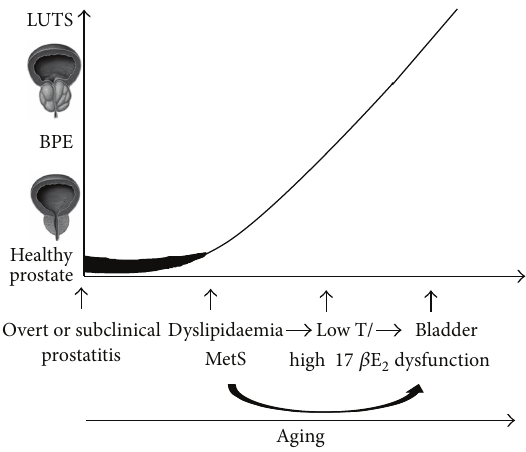
Figure 4: Graphical representation of a proposed multifactorial pathogenesis of benign prostatic hyperplasia/low urinary tract symptoms (BPH/LUTS). Symptomatic or asymptomatic prostate inflammation (very common in young individuals), in the presence of permissive factors such as metabolic syndrome (MetS), and in particular dyslipidemia, or an altered sex steroid milieu, can progress through prostate enlargement (BPE). The latter can or cannot be associated with LUTS, in particular in the presence of bladder dysfunction. Recent data indicates that MetS itself can also favour bladder